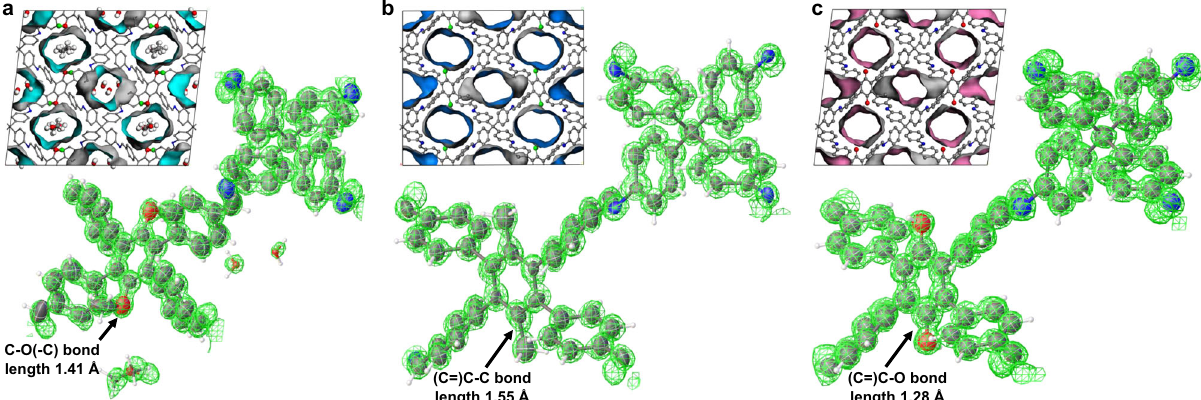
Fig. 4 Observed potential density maps and crystal structures. a 3D-TPB-COF-OMe, b 3D-TPB-COF-Me, and c 3D-TPB-COF-OH. Because of the high resolution and high completeness of the dataset after HCA, not only the framework atoms can be located directly, but also the functional groups and guest molecules can be determined with atomic precision by ab initio method. Color scheme: C in the framework, gray; O, red; N, blue; C in the functional groups